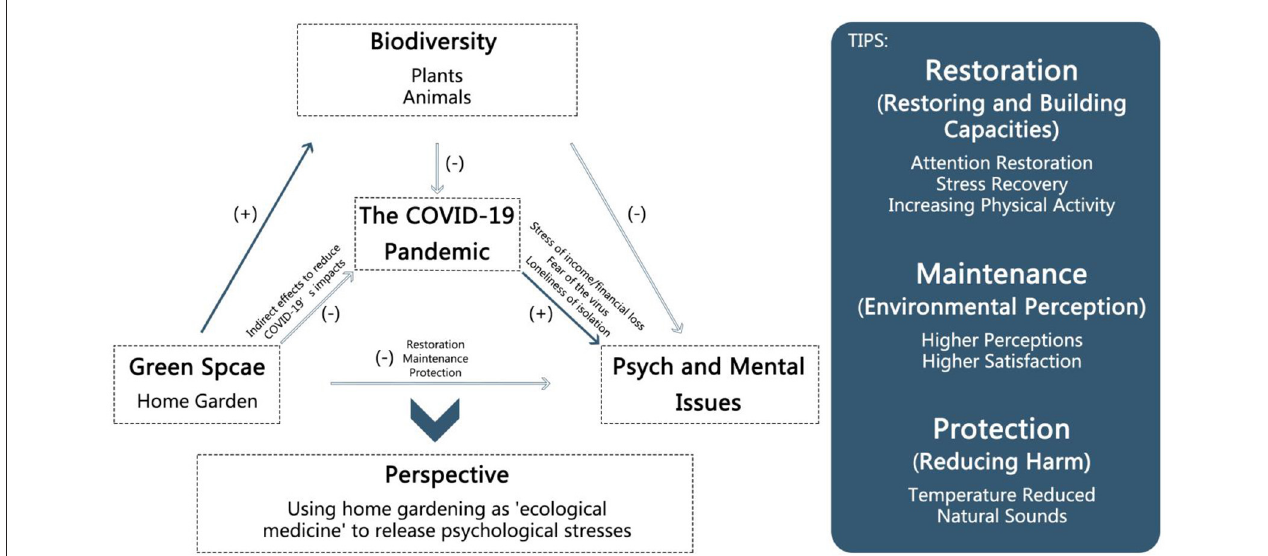
FIGURE 1 | The conceptual model of effects of green space/home garden on reducing mental problems under the pandemic (scenario) and benefiting biodiversity. It shows the logical framework of the green space with eco-healing effects. To control the COVID-19 pandemic, stay-at-home advisories or shelter-in-place policies were published. But, on the other hand, some mental issues including the feelings of stress, fear, and loneliness increased. Green space as one nature-based solution has been proven to relieve mental problems and stress through restoration (restoring and building capacities), maintenance (environmental perception), and protection (protection). And it also increases urban biodiversity through plants and animals. Due to the low likelihood of people accessing public green spaces, a home garden is mentioned. So the home garden, a kind of green space at a small scale, is good for mental health during the COVID-19 pandemic and has an indirect positive effect on combating the challenges of the pandemic. Thus, the idea of using green space, a kind of natural solution, to improve mental health and urban biodiversity not only during the pandemic but also in daily life is raised.